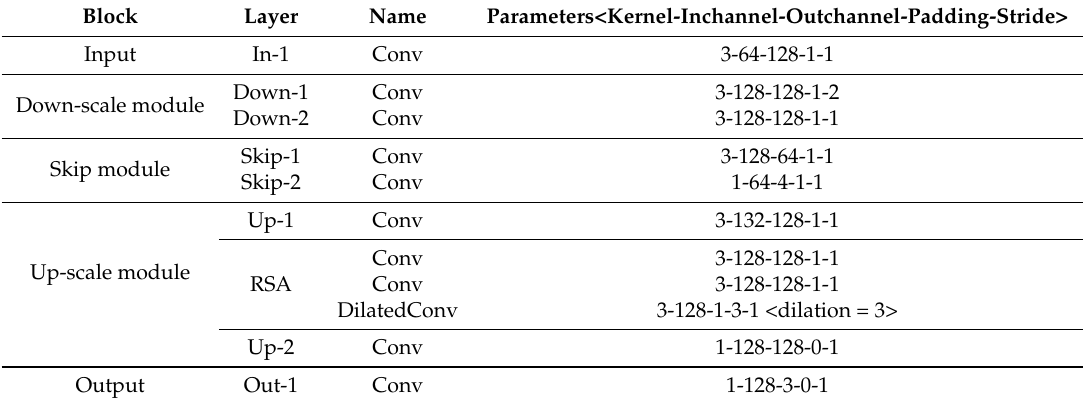
Table 1. The configurations of our generator network G